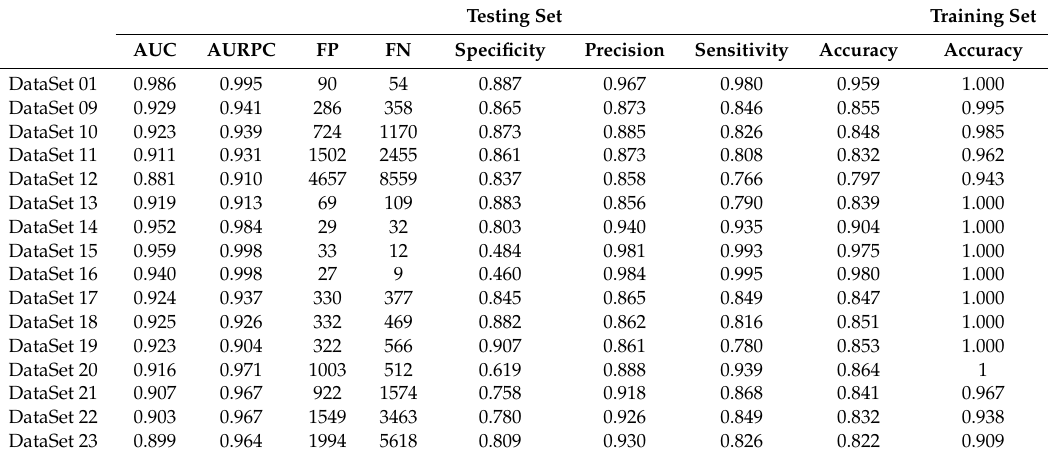
Figure 9. Recall-precision and ROC curves displaying the performance of LightGBM on testing datasets of Dataset 01, DataSet 09, DataSet 10, DataSet 11 and DataSet 12. Table 6. Further performance comparison between datasets on the method LightGBM. Testing Set Training